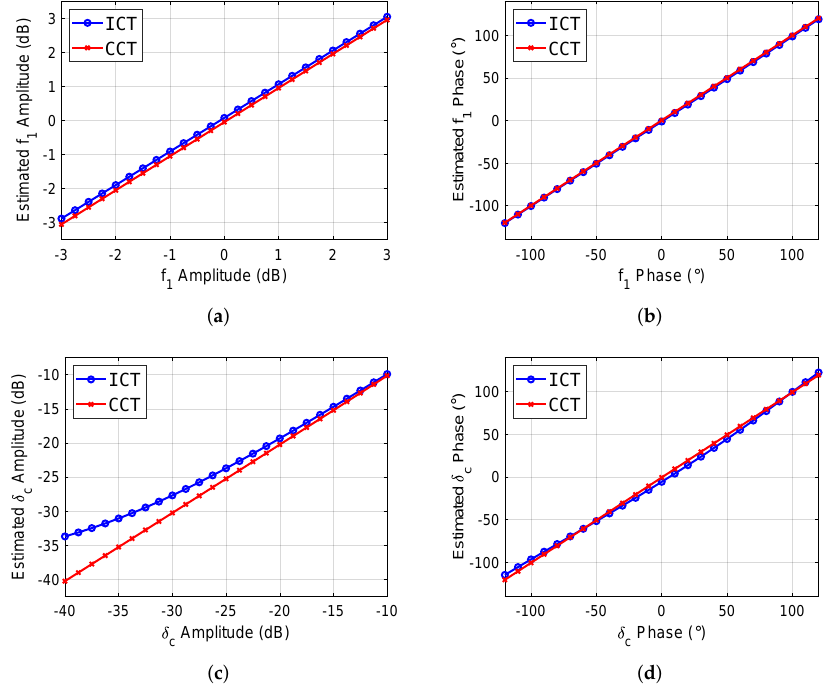
Figure 7. Simulation of distortion parameters estimation. ( a ) | f 1 | (dB). ( b ) arg { f 1 } ( ◦ ) . ( c ) | δ c | (dB). ( d ) arg { δ c } ( ◦ )